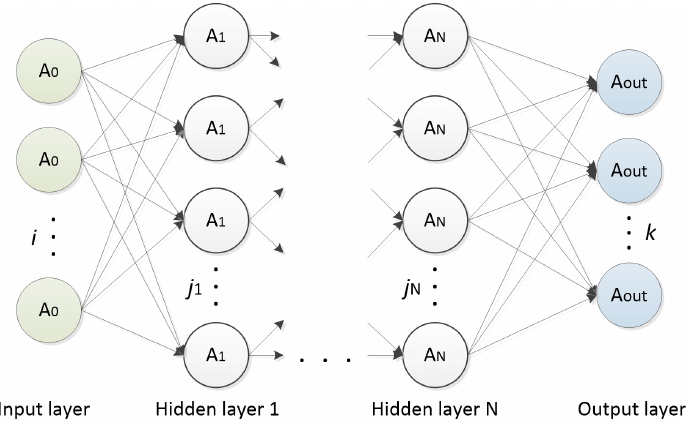
Figure 5. Diagram of a multi-layer feed-forward BP neural network; A 0 , A 1 , A N , A out —activation functions, N —number of hidden layers, i , j 1 , j N , k — numbers of neurons in layers.